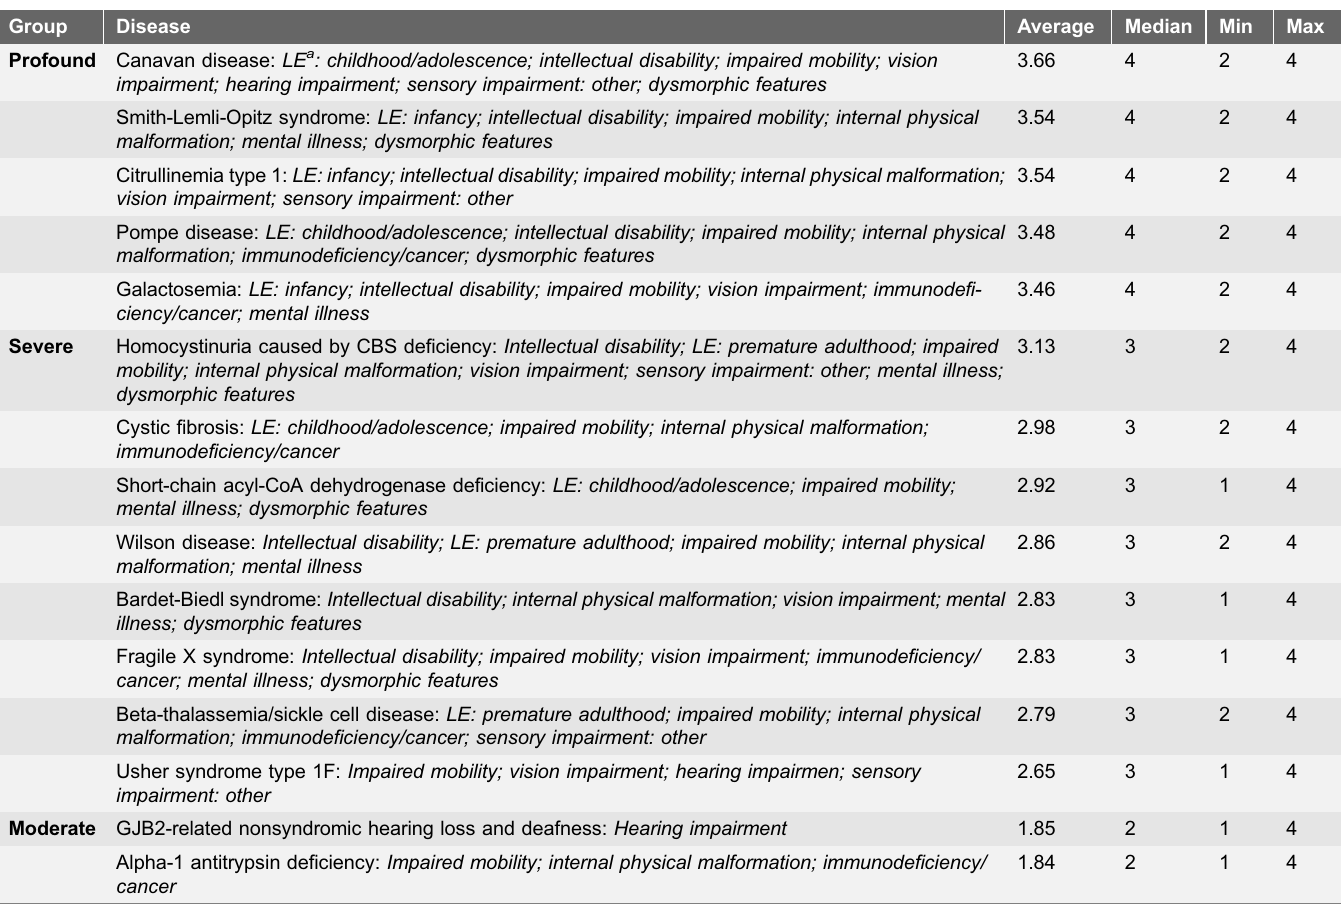
Table 3. Severity ratings and disease characteristics for each disease surveyed. Group